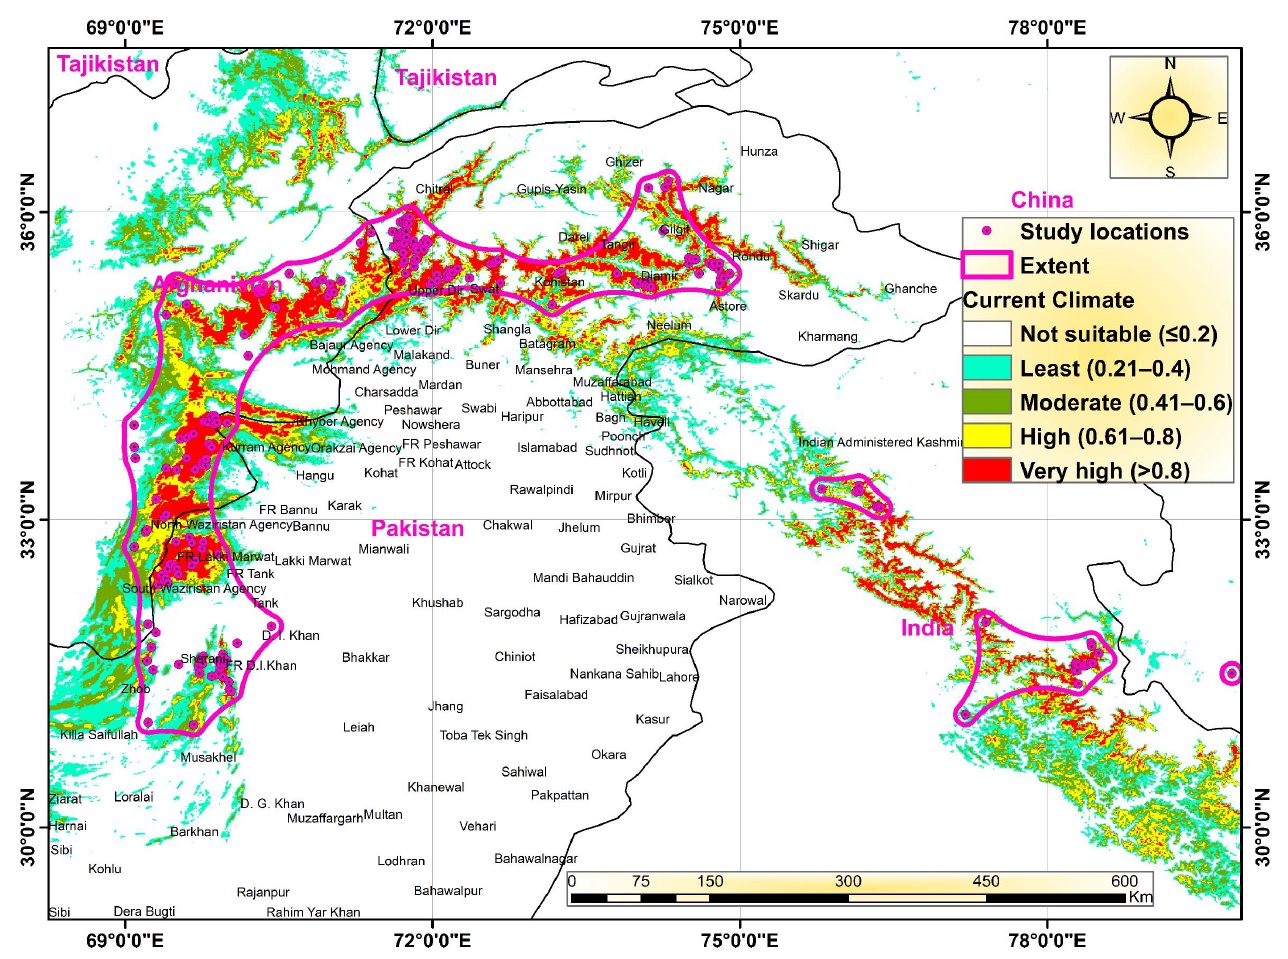
Figure 6. Predicted habitat suitability classification of Pinus gerardiana under current (1970–2000) climate scenario (Colour coding: No colour = No suitability; Turquoise = Least suitability; Green = Moderate suitability; Yellow = High suitability; Red = Very high suitability) Extent of occurrence (light purple) polygon is also added. Table 4. Habitat suitability classification (HSC) by using predicted probability of species occurrence values (five equal-sized intervals) and potential spatial distribution (area in km 2 ) of Pinus